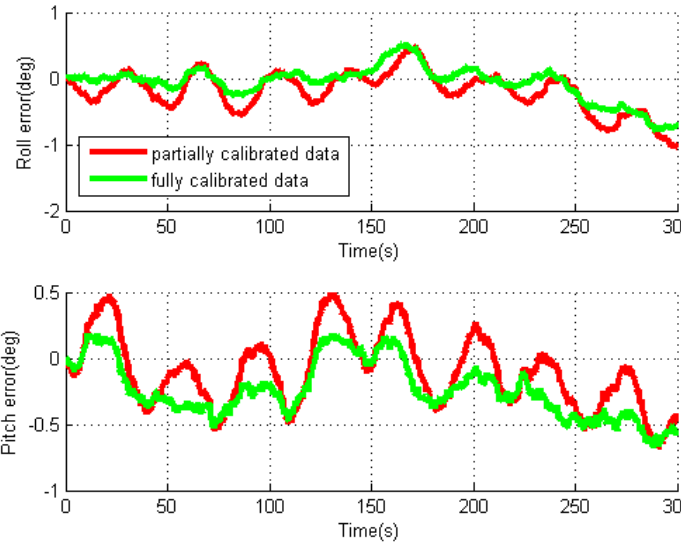
Figure 7. Roll and pitch errors for rotary INS with MTi-G.